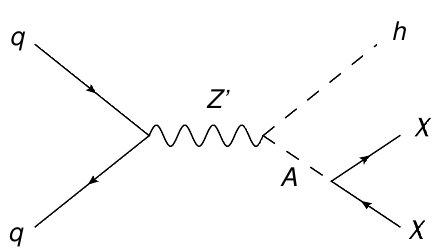
Figure 1. Feynman diagram for the production of the mono-Higgs signature in the Z 0